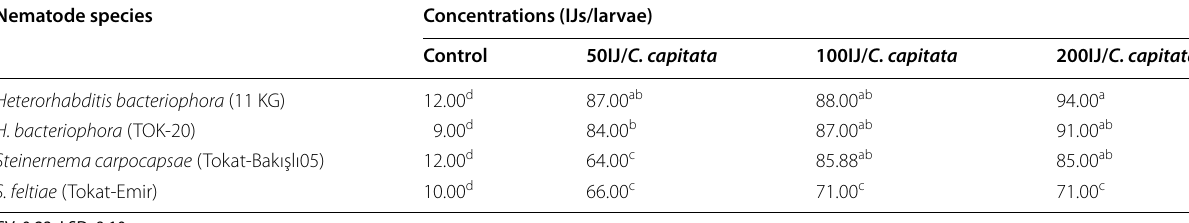
CV: 0.23, LSD: 9.10 Means followed by the same letter are not statistically different according to the Duncan test ( P Table 2 Effect of nematode species and concentrations on mortality rates of Medfly pupae